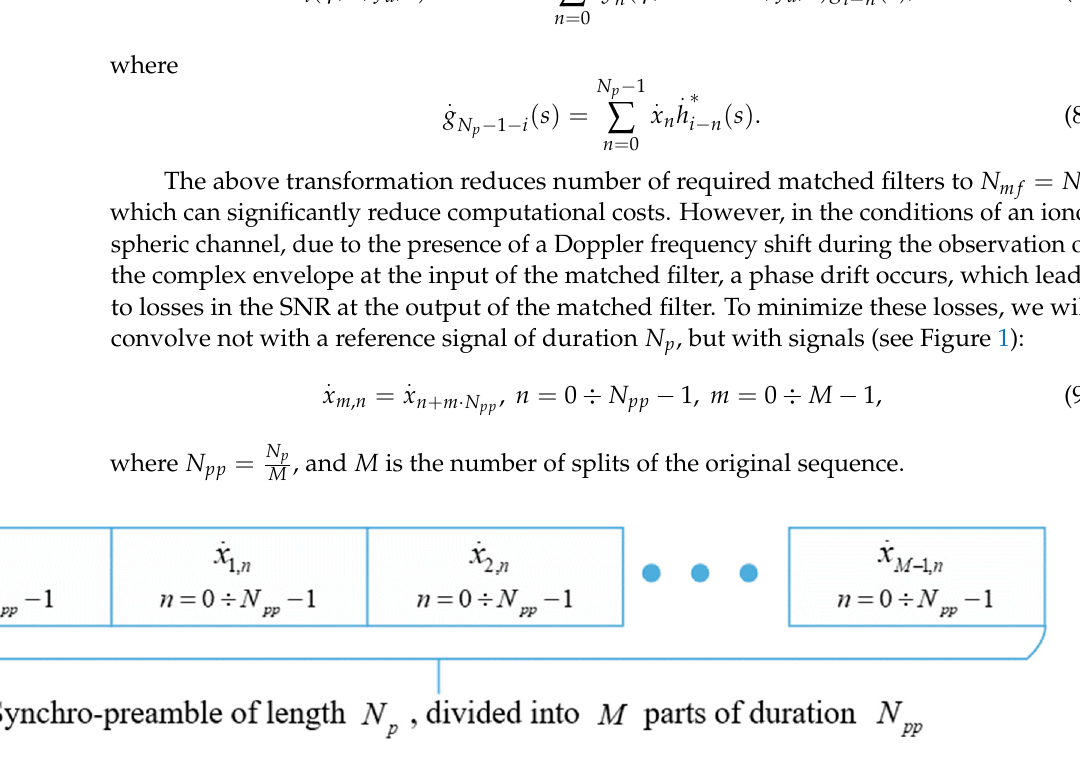
Figure 1. Reference signal divided into M parts. In this case, matched filtering can be performed using a series-matched filter, which is . x m , n a set of filters matched with sequences